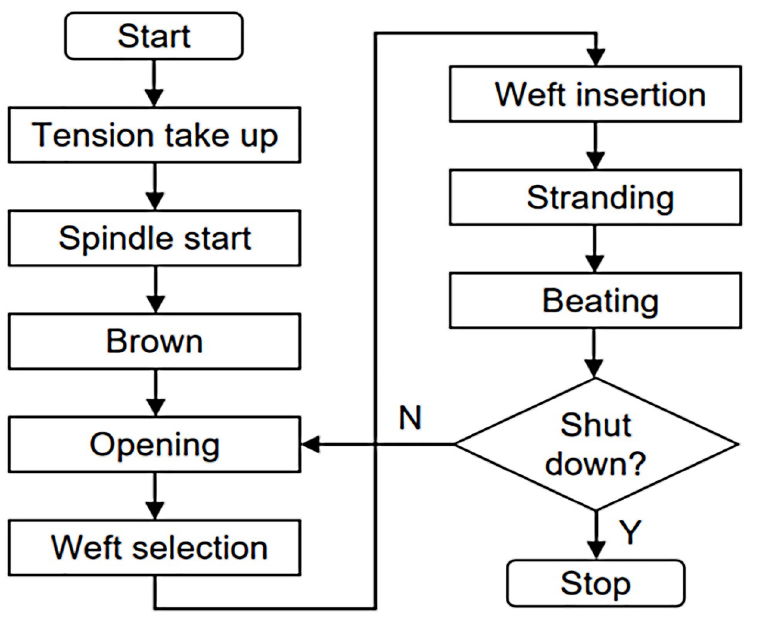
Fig 1. Overall process